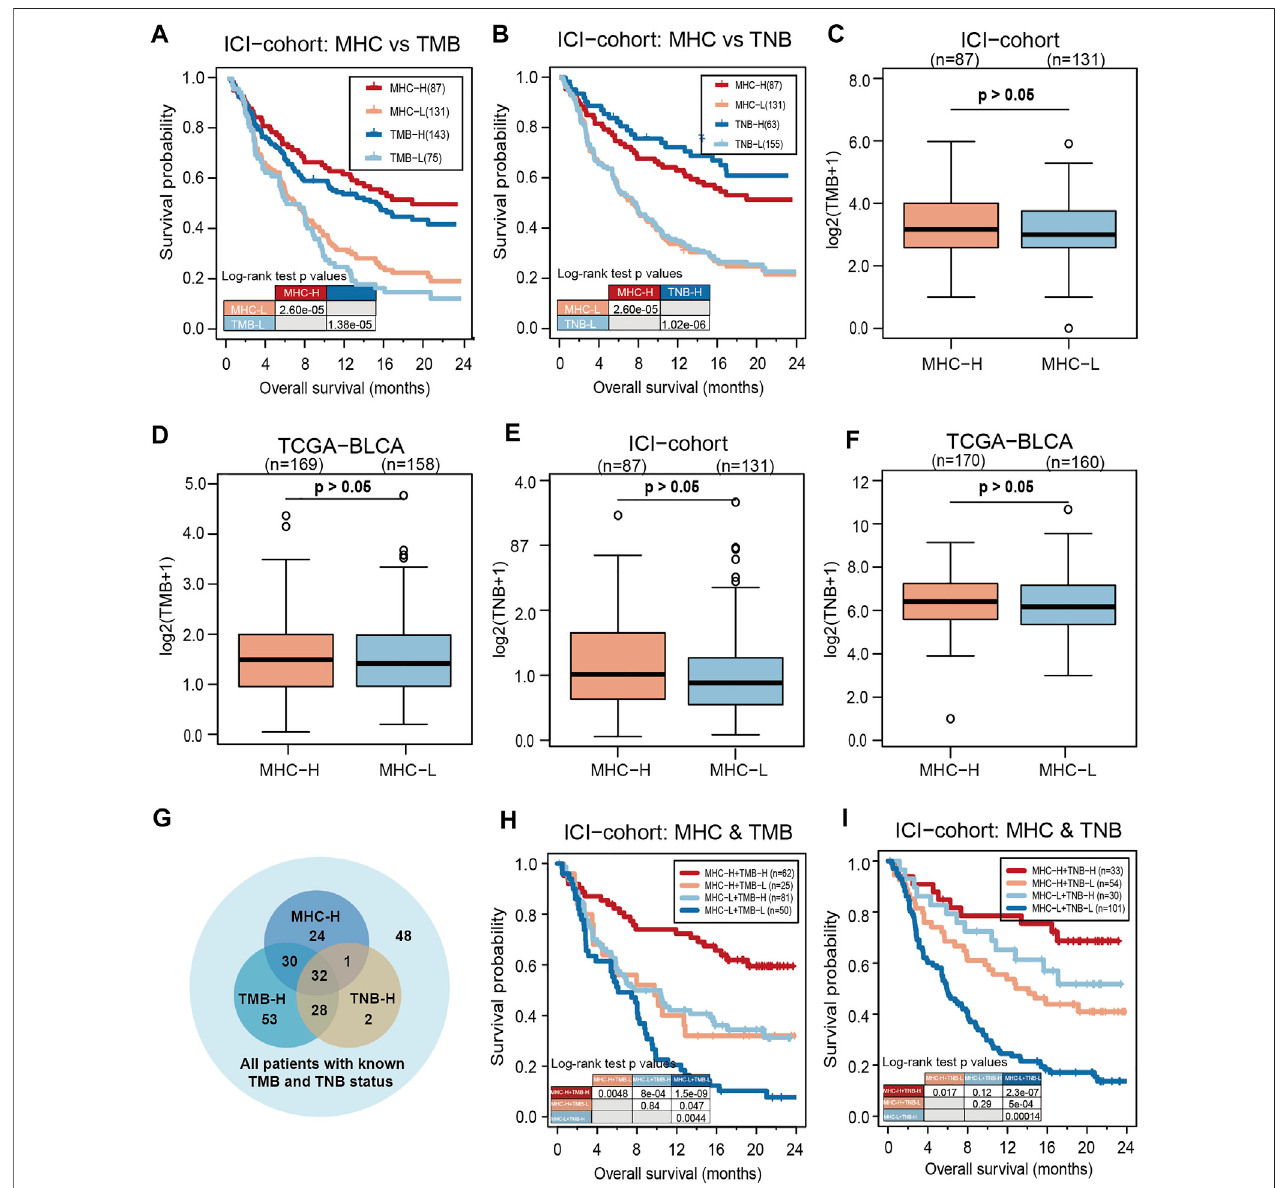
FIGURE3| MHC-IIsignatureissuperiortoTMBandslightlyinferiortoTNBaspredictivebiomarkers. (A) KManalysisshowedthatMHC-IIsignaturewassuperiorto TMBintheICI-cohort(MHC-IIsignature:HR=0.47,95%CI:0.34 – 0.65,P=2.60e-05;TMB:HR=0.49,95%CI:0.34 – 0.70,P=1.38e-05). (B) KManalysisshowedthat MHC-II signature wasslightly inferior toTNBin theICI-cohort(MHC-II signature: HR =0.47, 95%CI: 0.34 – 0.65, P=2.60e-05; TNB: HR=0.35, 95%CI: 0.25 – 0.49, P= 1.02e-06). (C,D) Boxplotsshowthattherewasnosigni fi cantrelationshipbetweenMHC-IIsignatureandTMBineithertheICI-cohort (C) ortheTCGA-BLCAcohort (D) (Wilcoxon Test, all P > 0.05). E-F. Boxplots showed that there was no signi fi cant relationship between MHC-II signature and TNB in either the ICI-cohort (E) or the TCGA-BLCA cohort (F) (wilcoxon test, all P > 0.05). (G) Venn diagram showed the distribution in the MHC-H and MHC-L groups of patients with known TMB and TNB statusin the ICI-cohort( n = 218). (H) KM curves show the comparison ofMHC-H + TMB-H, MHC-H + TMB-L, MHC-L + TMB-H and MHC-L + TMB-L in ICI-cohort( n = 218). (I) KM curves show the comparison of MHC-H + TNB-H, MHC-H + TNB-L, MHC-L + TNB-H and MHC-L + TNB-L in the ICI-cohort ( n = 218).